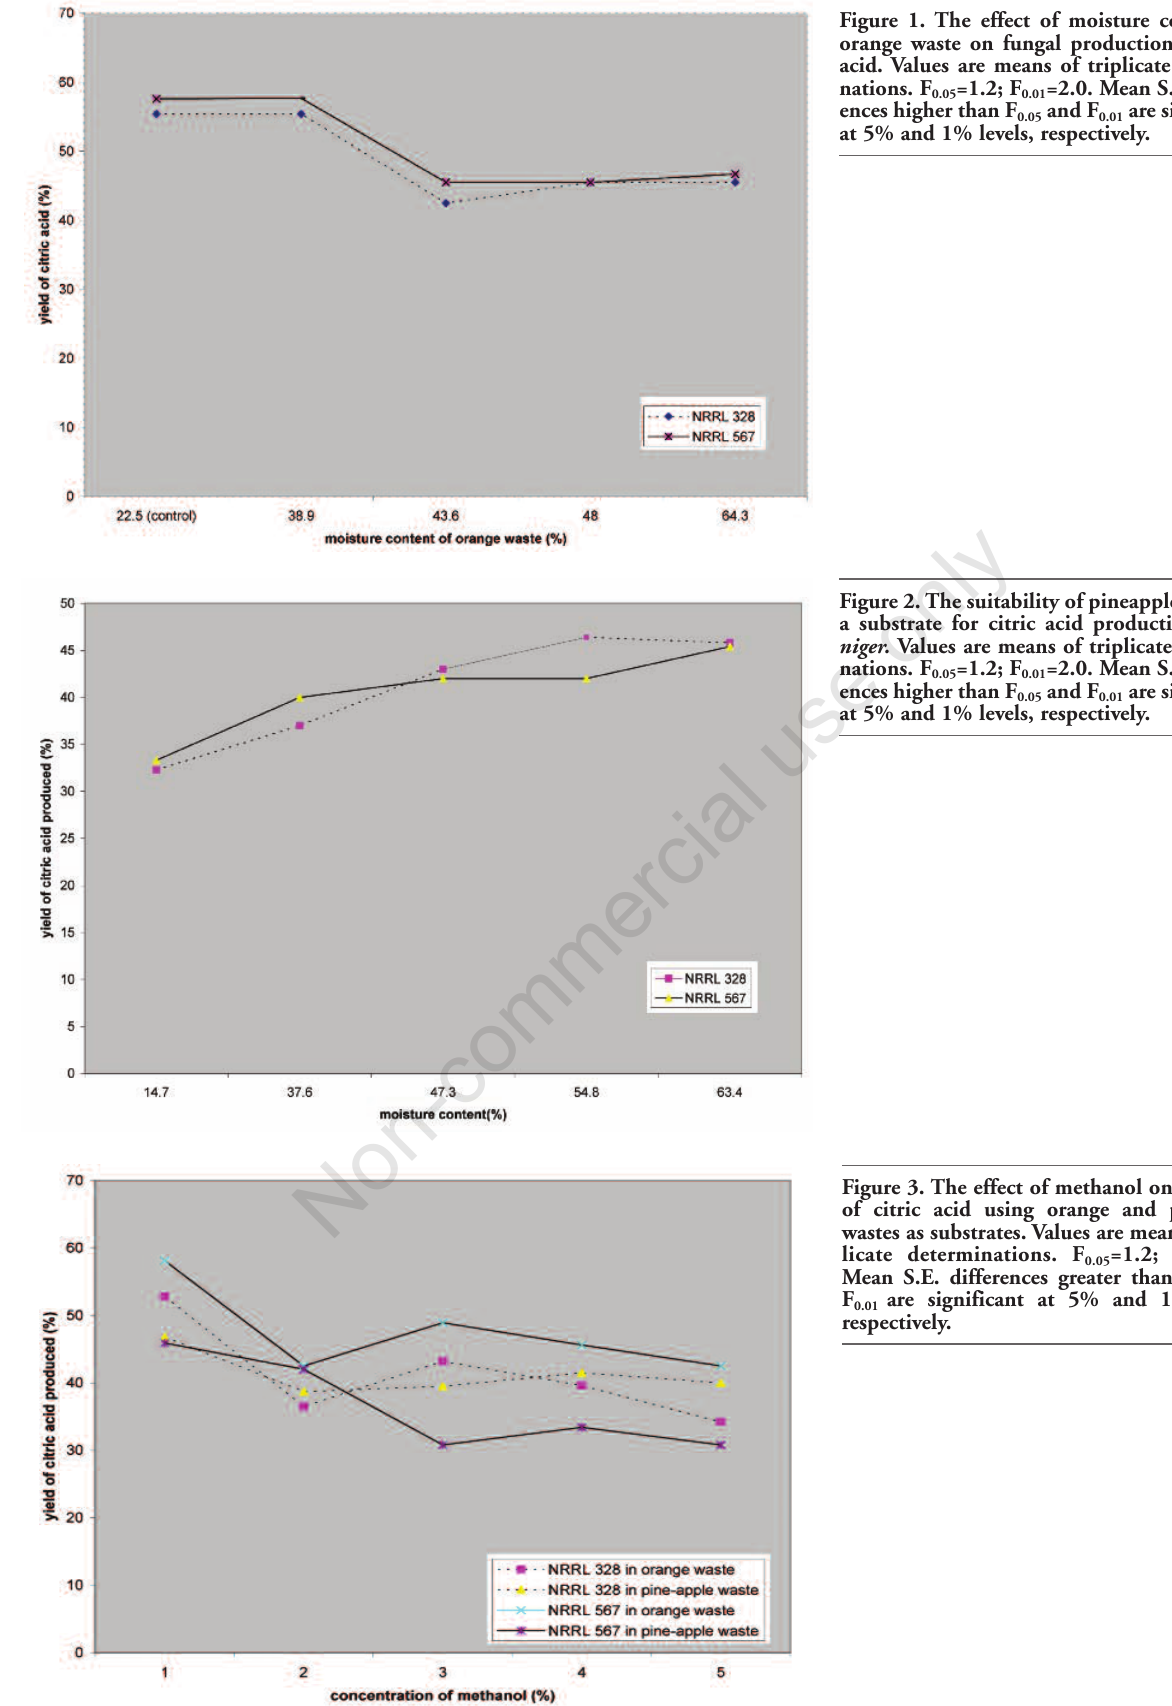
Figure 1. The effect of moisture content of orange waste on fungal production of citric acid. Values are means of triplicate determi- nations. F =1.2; F =2.0. Mean S.E. differ- 0.05 0.01 ences higher than F and F are significant 0.05 0.01 at 5% and 1% levels, respectively.